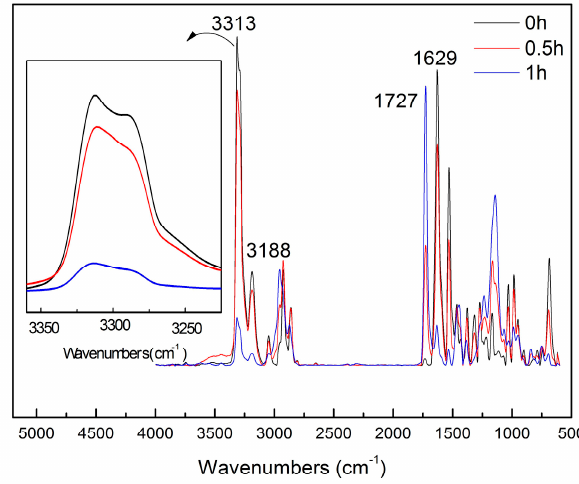
Figure 8. FTIR spectra of ADH/P(MMA-BA-MAA) hybrid films after different absorption time.